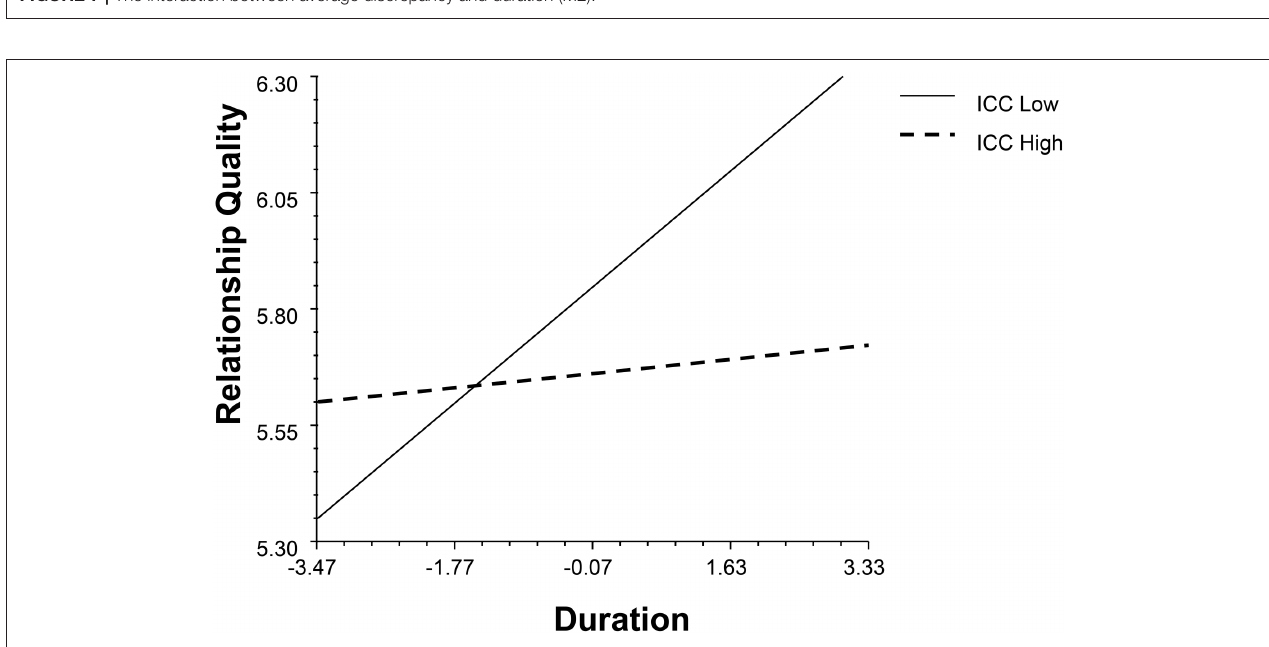
FIGURE 7 | The interaction between average discrepancy and duration (M2).